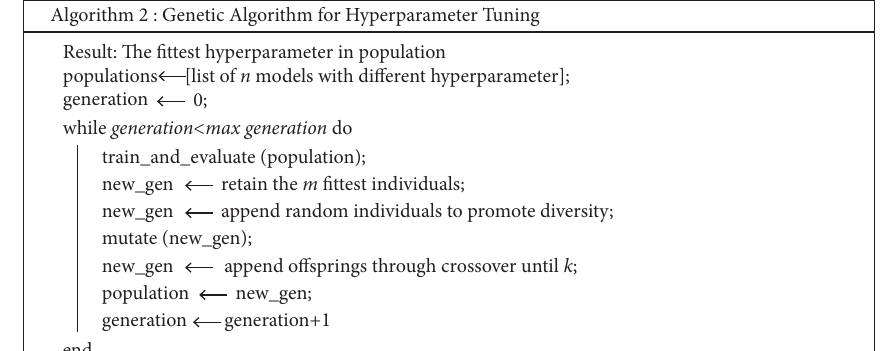
Figure 8: Parameters tuning of the proposed method.